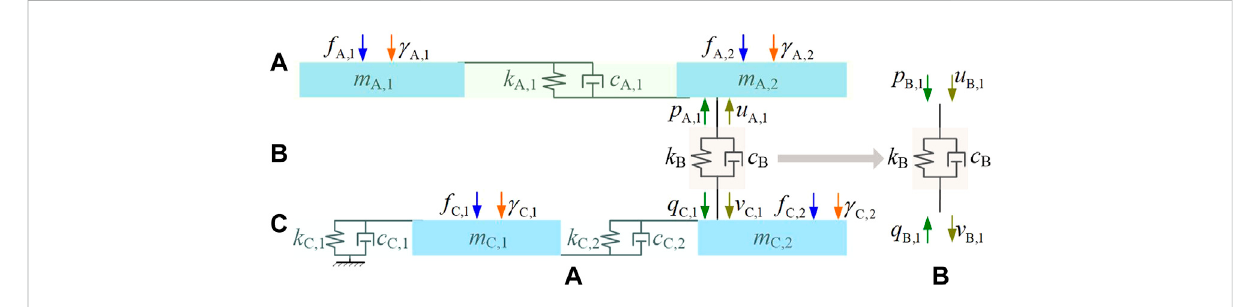
FIGURE 4 ThreelayerMIMOmodelofthe4-DoFbuildingisolationsystem.(A)ThethreelayerMIMOmodel,(B)Theforcesandvelocitiesoftheeisolatorin layer